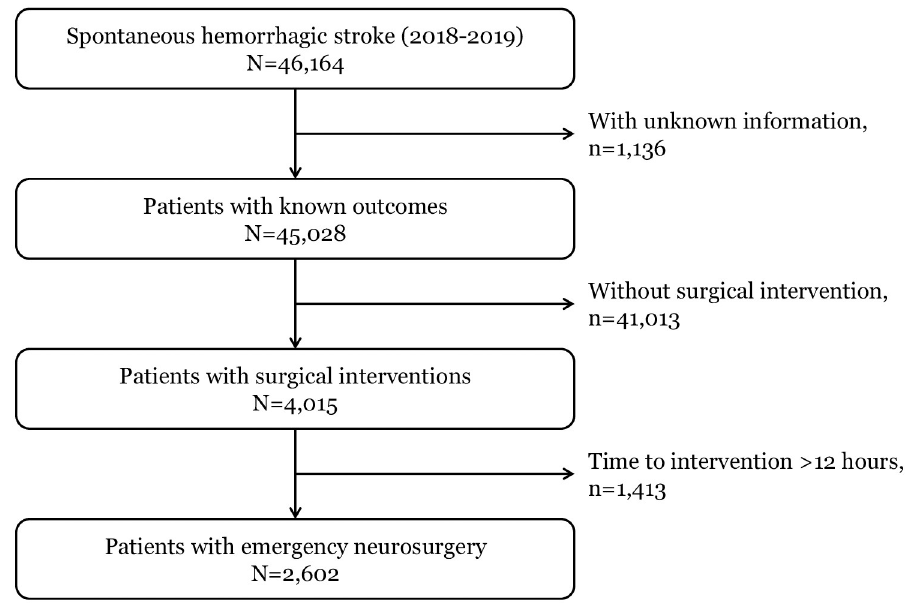
Fig 1. Study population flow.